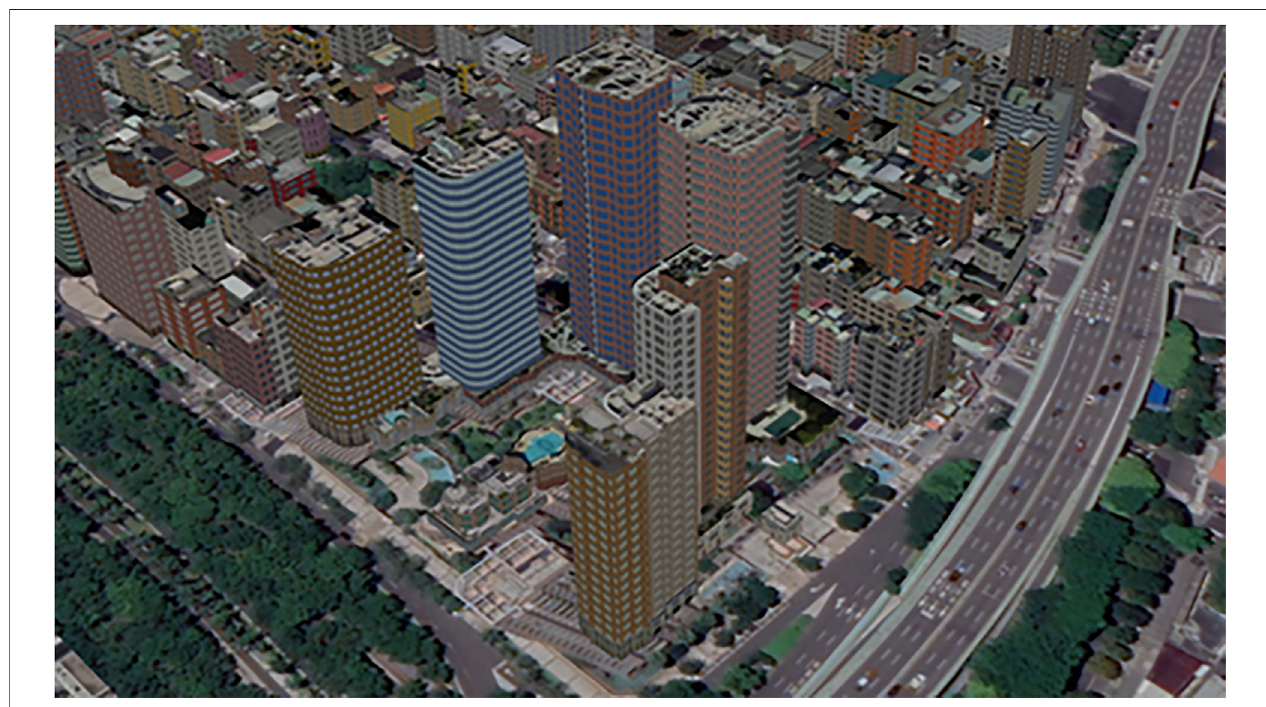
FIGURE 12 | 3D urban visualization with the MDUES platform.